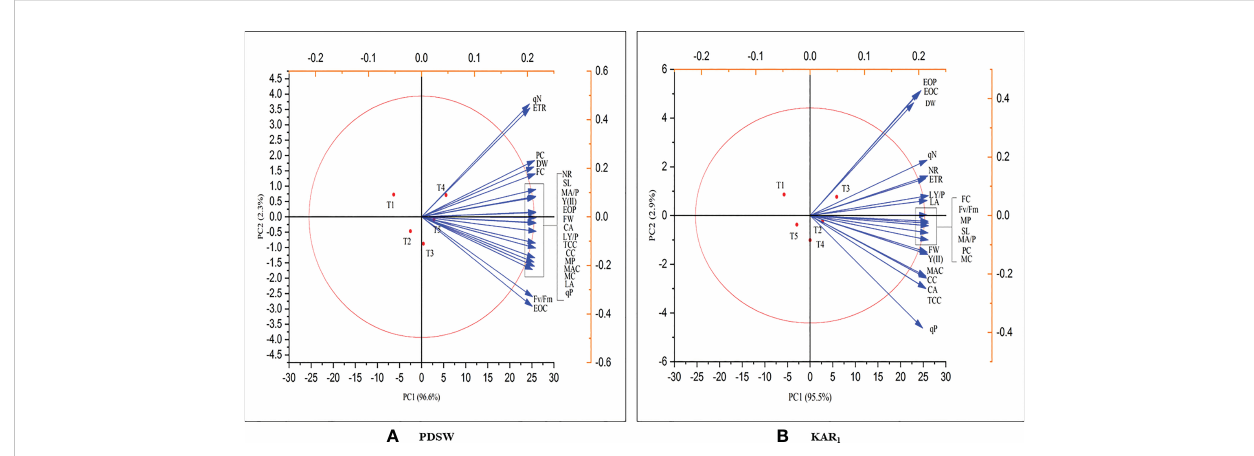
FIGURE 7 Principal correlation analysis (PCA) shows the positive correlation of the response of (A) PDSW and (B) KAR 1 in terms of growth, physiological attributes, essential oil yield and active constituents of mint plant. Foliar application with PDSW and KAR 1 positively enhances SL, shoot length; FW, fresh weight; DW, dry weight; LA, leaf area; LY/P, leaf yield per plant, NR, nitrate reductase; CA, carbonic anhydrase; PC, phenol content; FC, fl avonoid content; EOC, essential oil content; EOP, essential oil production, MC, menthol content; MP, menthol productivity; MAC, menthyl acetate content; MAP, menthyl acetate productivity; TCC, total chlorophyll content; CC, carotenoid content; Fv/Fm, chlorophyll fl uorescence; qP, photochemical quenching; qN, (non-photochemical quenching); Y (II), effective quantum yield of photosystem II; and ETR, electron transport